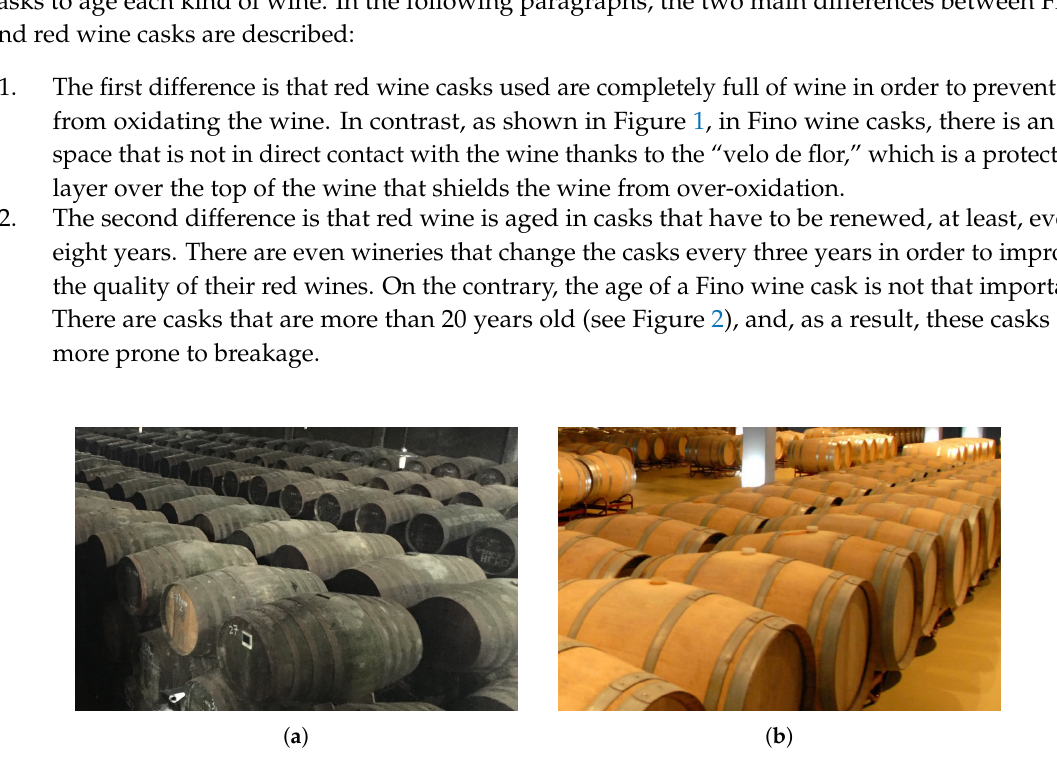
Figure 2. Fino wine cask vs. red wine cask. ( a ) Fino wine cask; ( b ) red wine